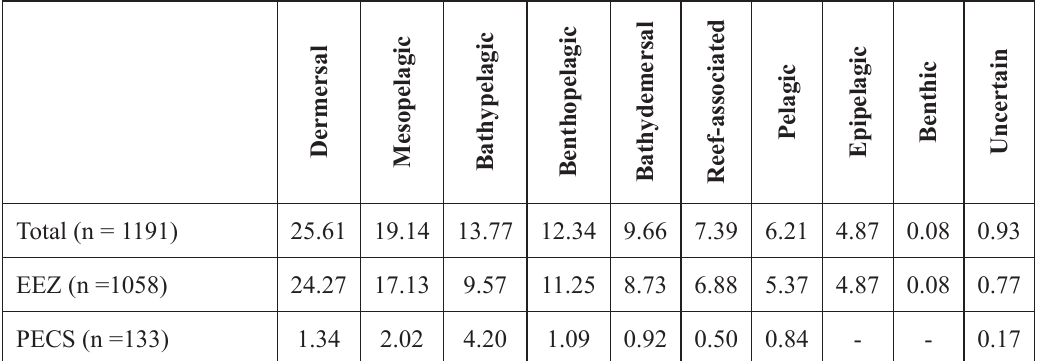
Table 5. Proportion of fish species according to preferred vertical habitat, distributed by the total study area, EEZ plus territorial waters, and the area corresponding to the proposed extension of the Portuguese continental shelf (PECS).